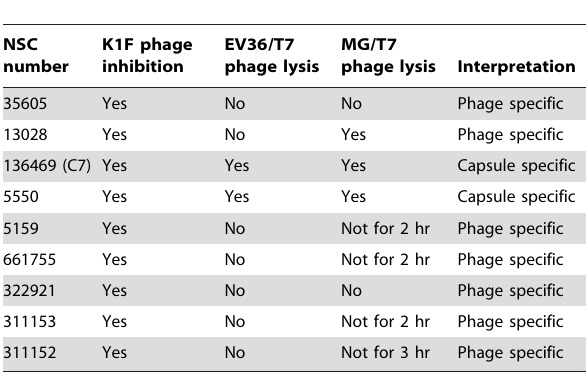
Table 2. Summary of capsule-specific and phage specific effects of selected lead